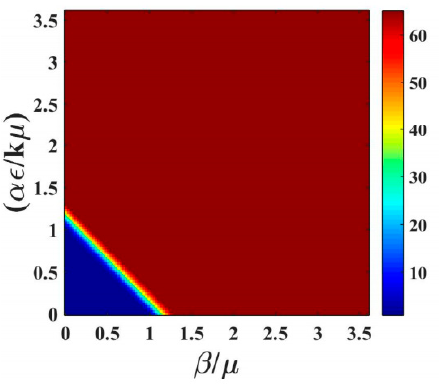
β 𝛽 𝜇 (cid:3415) , and 𝑅 (cid:3036)(cid:3041)(cid:3031)(cid:3036)(cid:3045)(cid:3032)(cid:3030)(cid:3047) = µ , and R indirect =